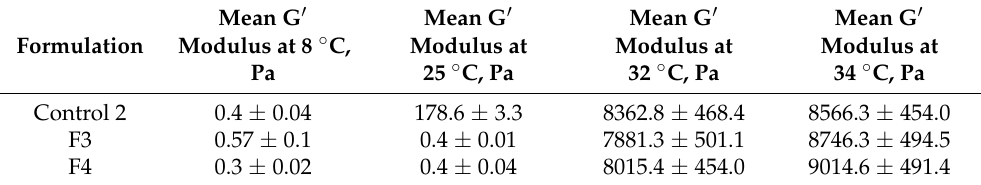
Table 4. Mean G’ modulus of Control 2, F3 and F4 at different temperatures.